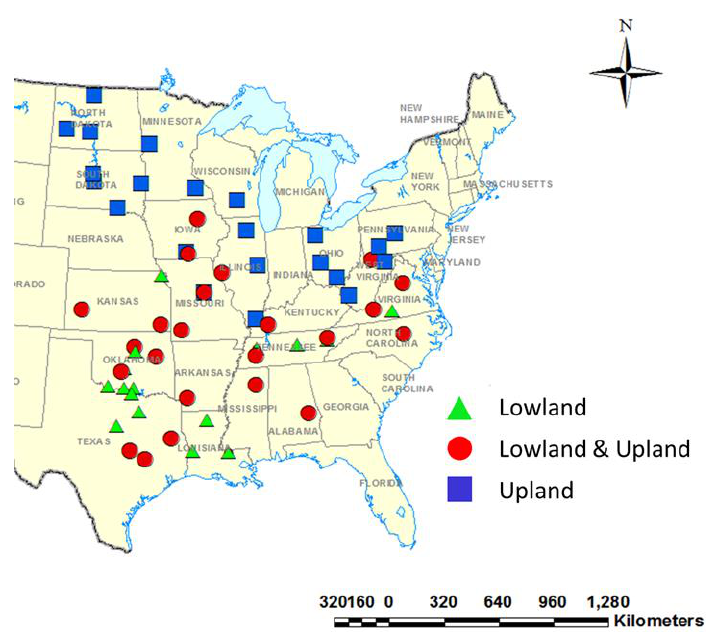
Figure 1. Locations with switchgrass biomass yields across the United States reported in literature reviews. Green triangle, red circle, and blue square indicate study locations where only switchgrass lowland cultivars, both switchgrass lowland and upland, and only switchgrass upland cultivars were conducted, respectively.